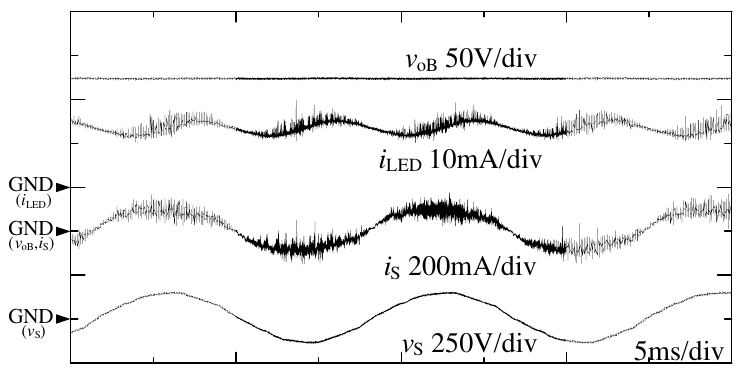
Figure 17. Experimental results of the proposed cooperative control method when the reference LED current I ∗ is 1.5 A. LED